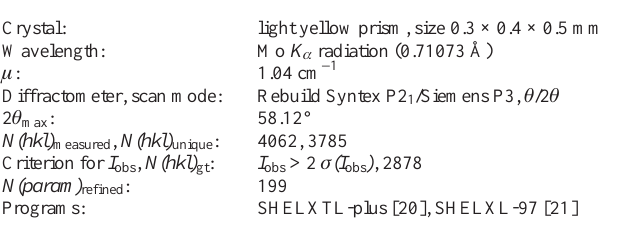
Table 1. Data collection and handling.